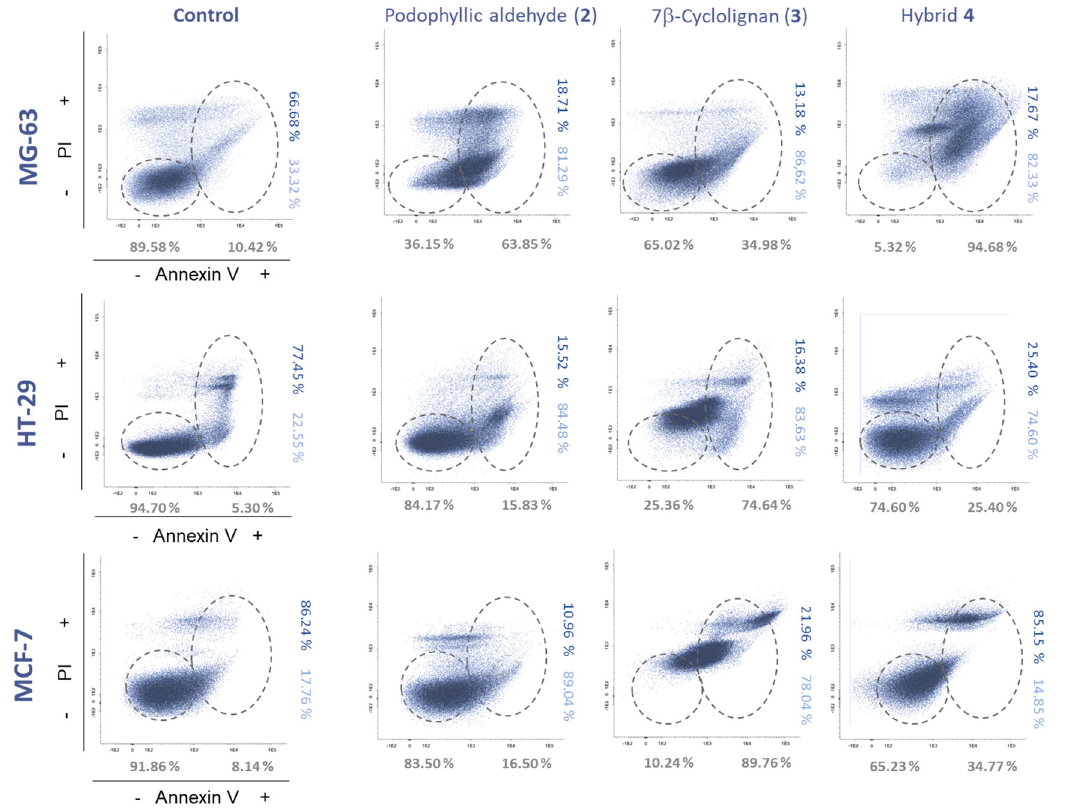
Figure 4. Apoptosis assays performed by flow cytometry with the compounds 2 – 4 in the cell lines MG-63 (osteosarcoma), HT-29 (colorectal cancer) and MCF-7 (breast cancer) at 24 h of incubation at 10 µ M and control with vehicle (DMSO, < 0.001%). PI, propidium iodide. % Annexin V − /+ (grey), annexin V+/PI − (light blue) and annexin V+/PI+ (dark blue).